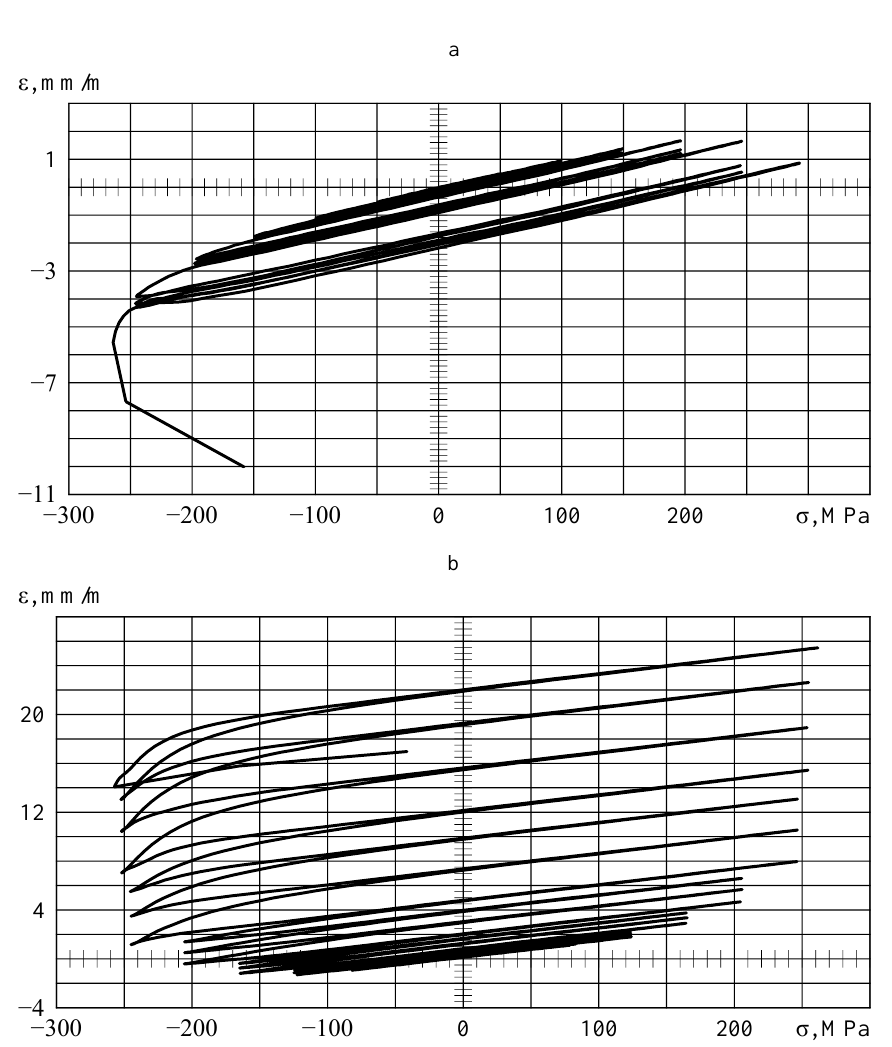
Fig. 2. Inelasticity of specimen 1 (a) and specimen 2 (b) at step increase of loading